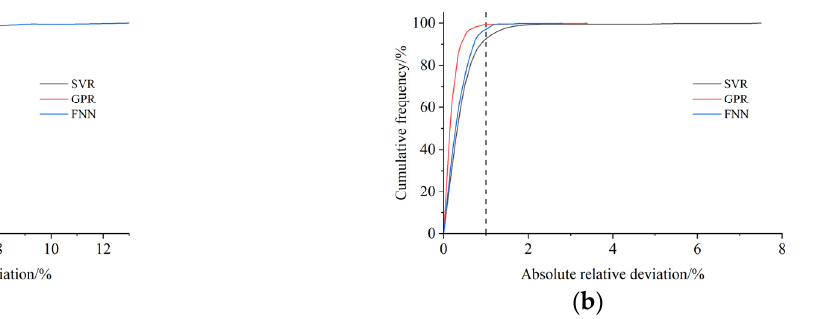
Figure 11. The cumulative frequency of absolute relative deviation: ( a ) H ip 2 and ( b ) η d .